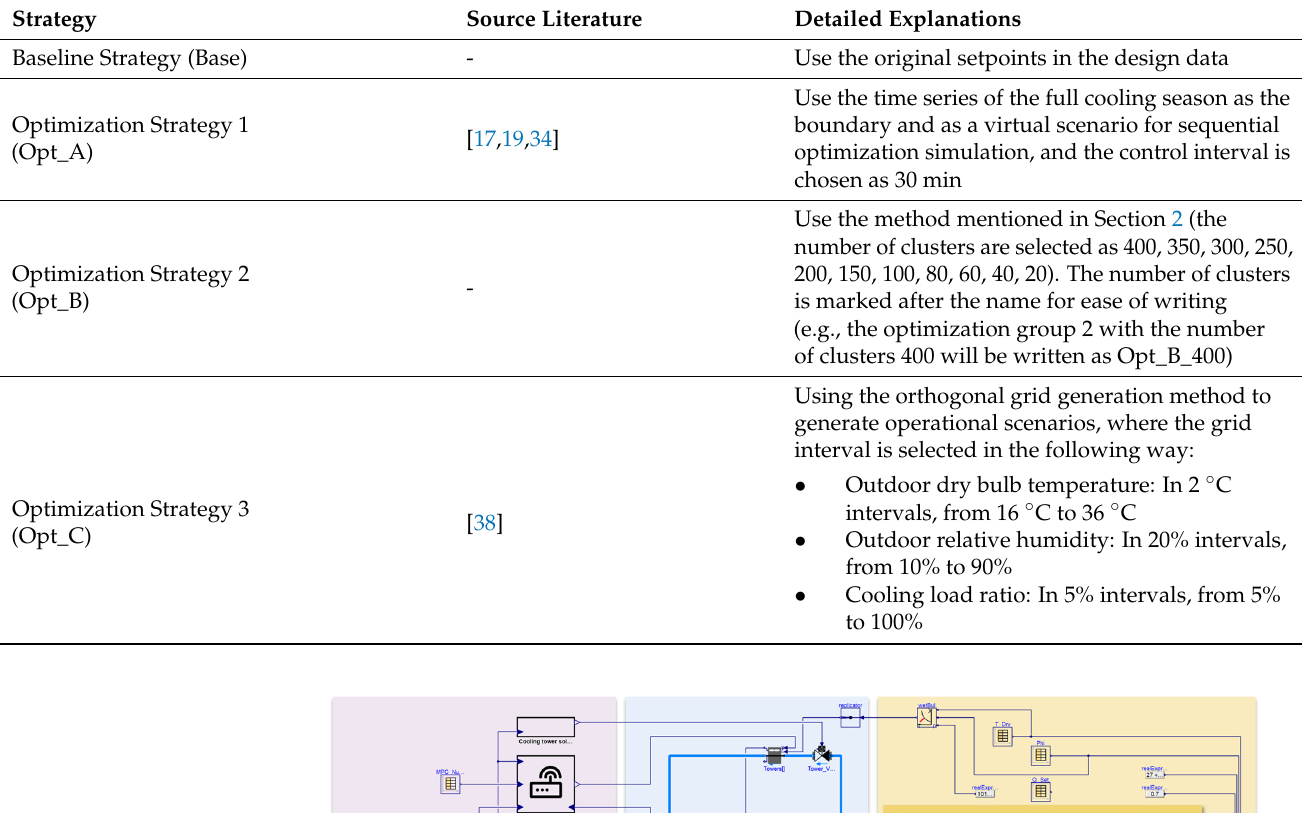
Table 3. Experimental design.